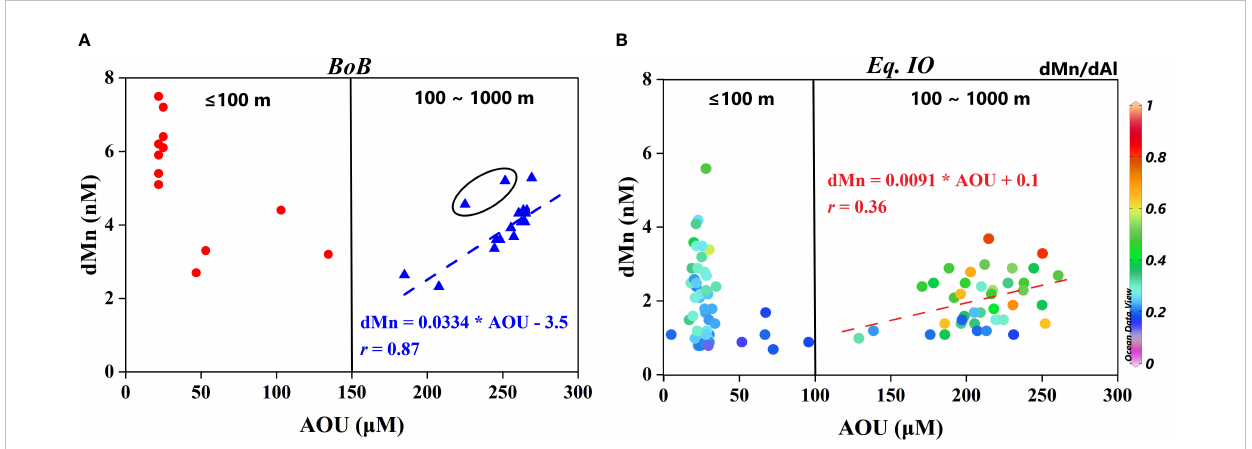
FIGURE 10 (A) dMn variation with AOU in the BoB. Red dots represent layers above (including) 100 m. Blue triangles represent layers from 100 to 1,000 m; the two triangle dots in the ellipse come from 120 and 200 m of station I110, where the advection of dMn-rich Andaman Sea was obvious. Blue dash is the linear line of AOU and dMn between 100 and 1,000 m, and blue font is its fi tting equation. (B) dMn variation with AOU in the Eq. IO, with value of dMn:dAl on each dot (showing as a color bar). The dots on the left of black solid line represent layers above (including) 100 m, while on the right are in the range of 100 – 1,000 m. Red dash is the linear line of AOU and dMn between 100 and 1,000 m, and red font is its fi tting equation. dMn, dissolved manganese; AOU, apparent oxygen utilization; BoB, Bay of Bengal; dAl, dissolved